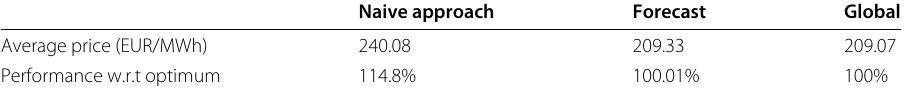
Table 6 Comparison of results for the operation strategy with regard to cost